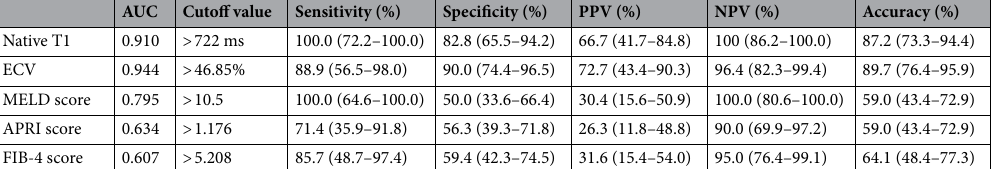
Table 3. Diagnostic performance of hepatic native T1 and MRI-derived extracellular volume fraction as well as clinical scores of liver disease severity for the differentiation between patients with liver cirrhosis of Child– Pugh classes B and C. ECV extracellular volume fraction, MELD model of end-stage liver disease, APRI score aspartate aminotransferase to platelet ratio index, FIB-4 score fibrosis 4 score, AUC area under the curve, PPV positive predictive value, NPV negative predictive value.